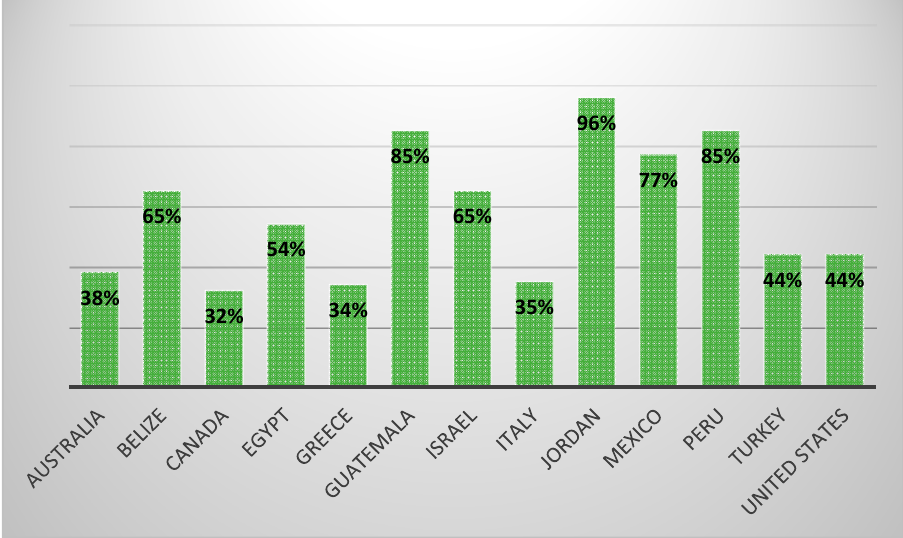
Figure 2. % Respondents solicited off-site for purchase of looted objects.